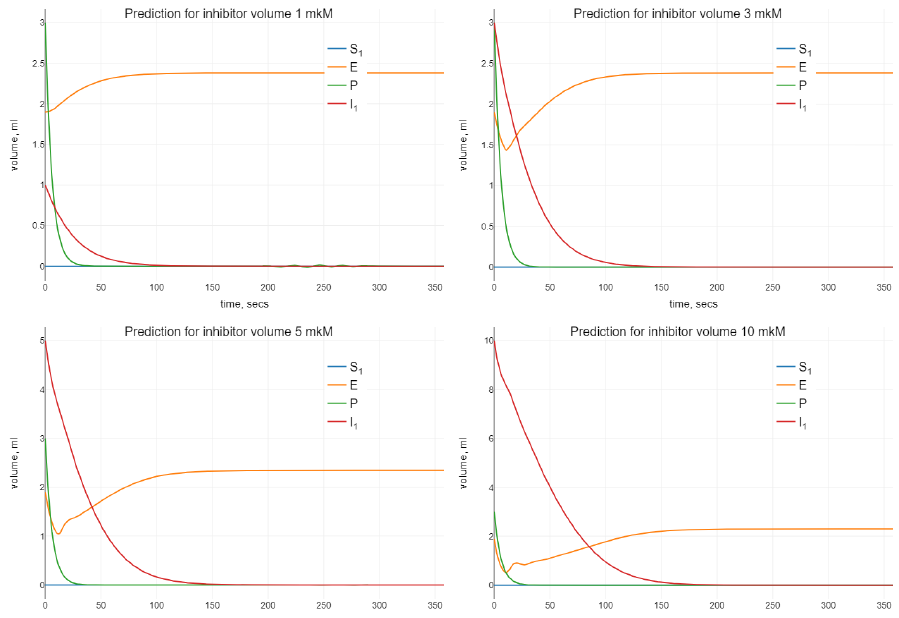
Figure 4. Numerical simulation with the help of (24) for different initial values of